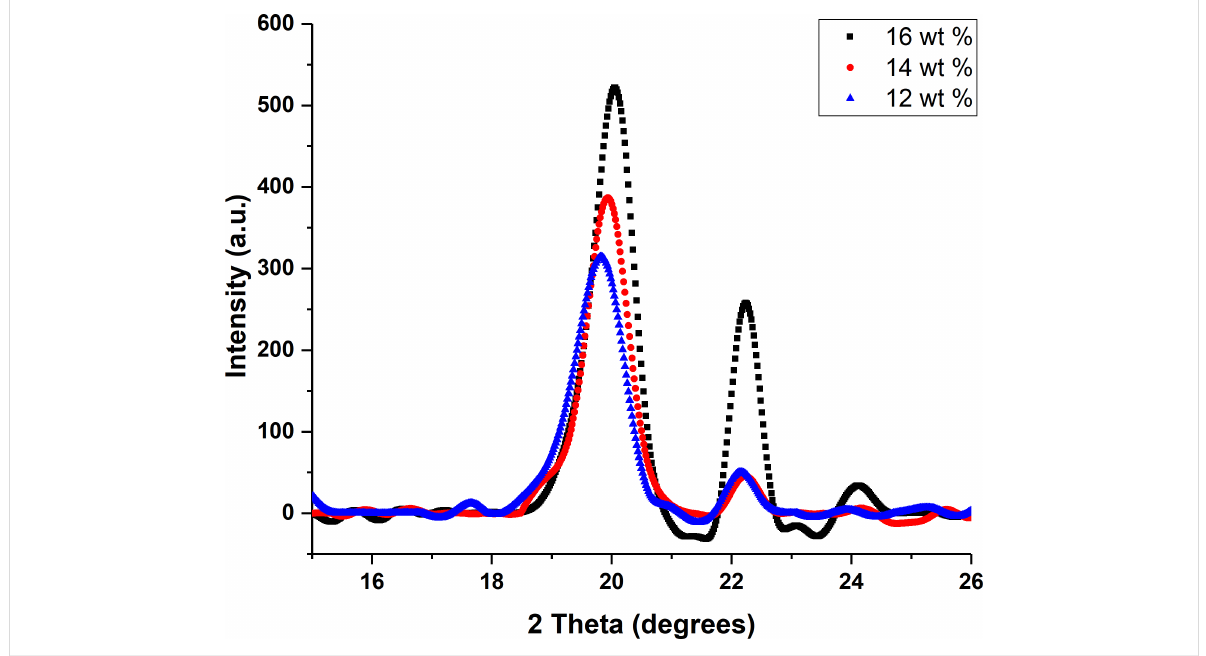
Figure 3: X-ray diffraction pattern of nanofibers at various concentrations.